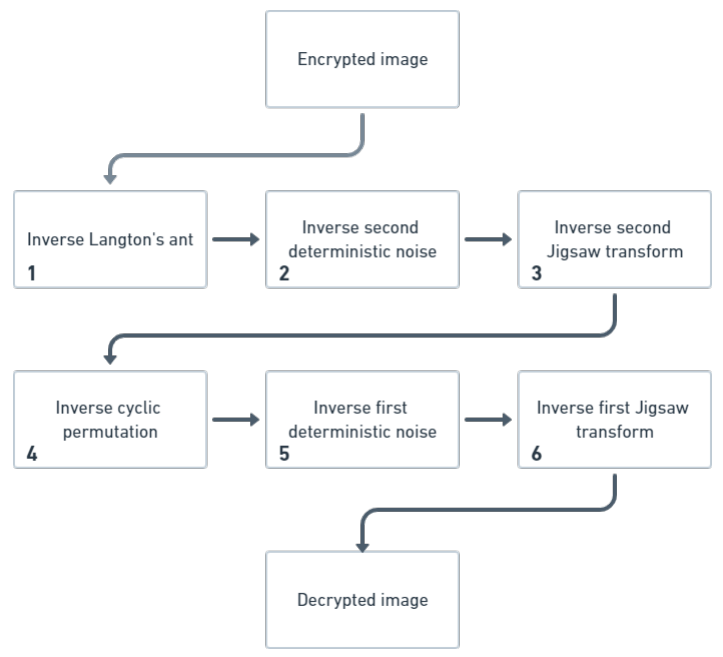
Figure 11. The six steps of the decryption